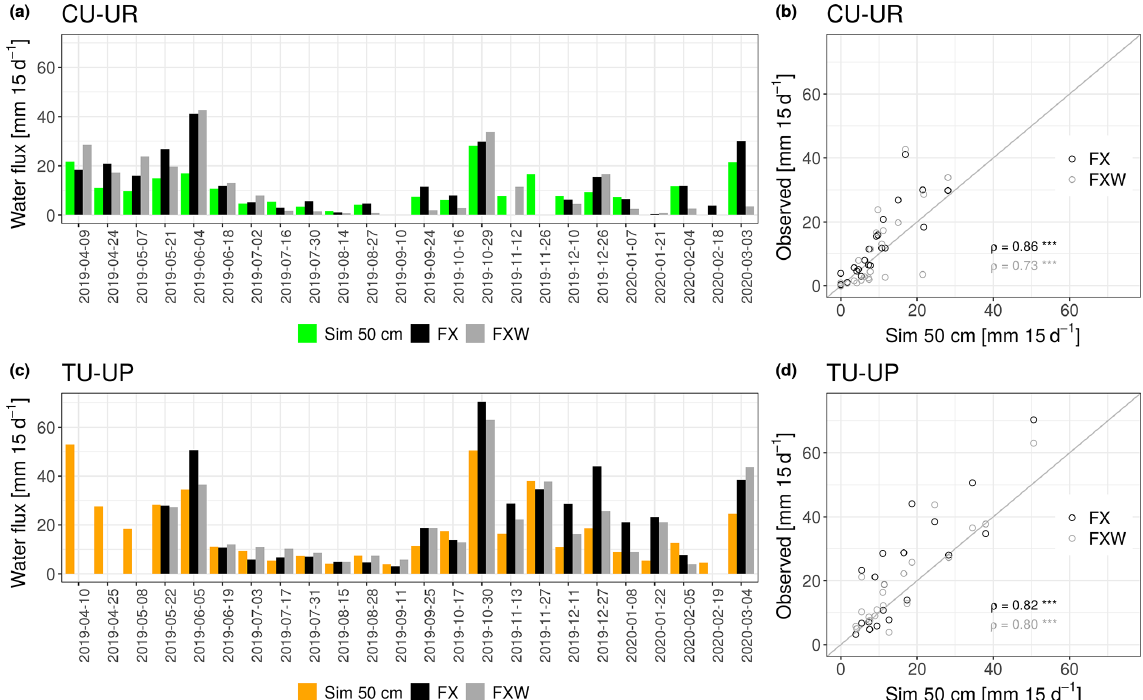
Figure 5. Panels (a) and (c) show the biweekly temporal series of simulated (Sim) and observed water fluxes (FX, FXW). Panels (b) and (d) show the correspondence between the simulated and observed water fluxes. Water fluxes were measured by two fluxmeters (FX: without wick, FXW: with wick) installed at 50cm depth in each profile. The Spearman correlation coefficients ( ρ ) and their significance are given in the scatterplots (with levels of significance ∗ , ∗∗ , and ∗∗∗ corresponding to p< 0 . 05, p< 0 . 01, and p< 0 .